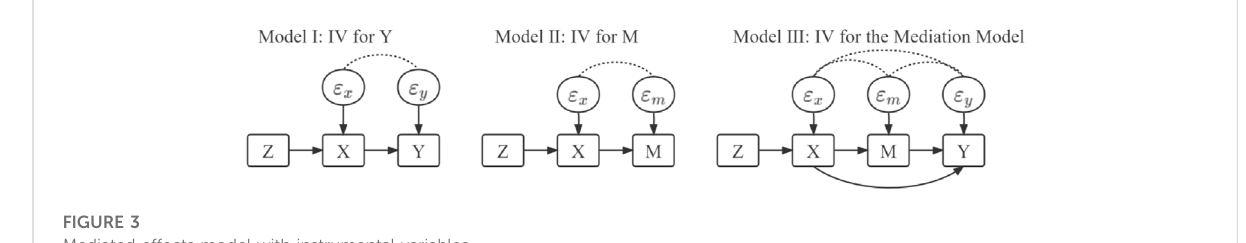
FIGURE 3 Mediated effects model with instrumental